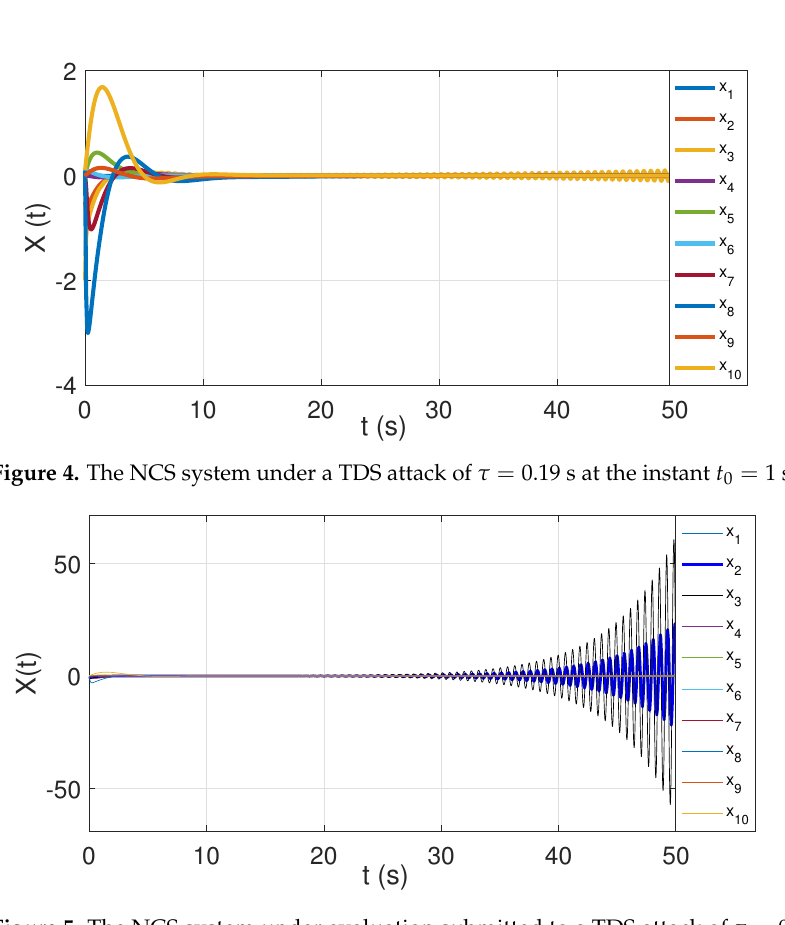
Figure 5. The NCS system under evaluation submitted to a TDS attack of τ = 0.20 s at the instant t 0 = 1